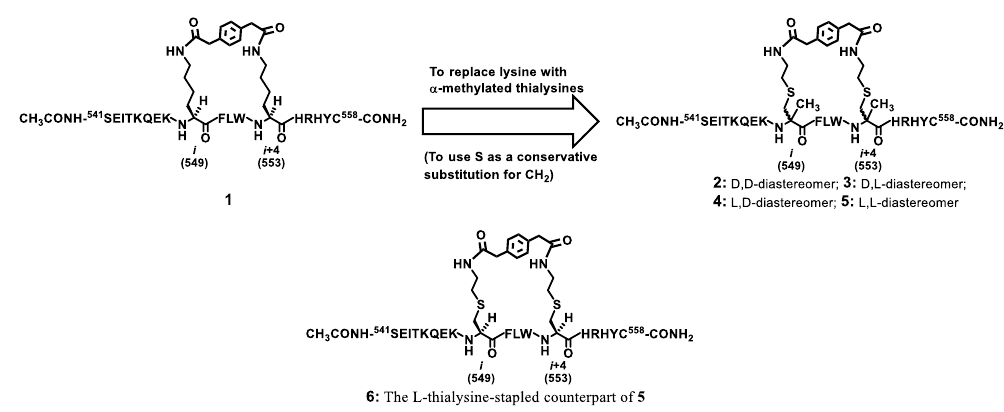
Figure 1. The design of the stapled peptides 2 – 6 , analogs of the stapled peptide 1 that our laboratory discovered recently [16].